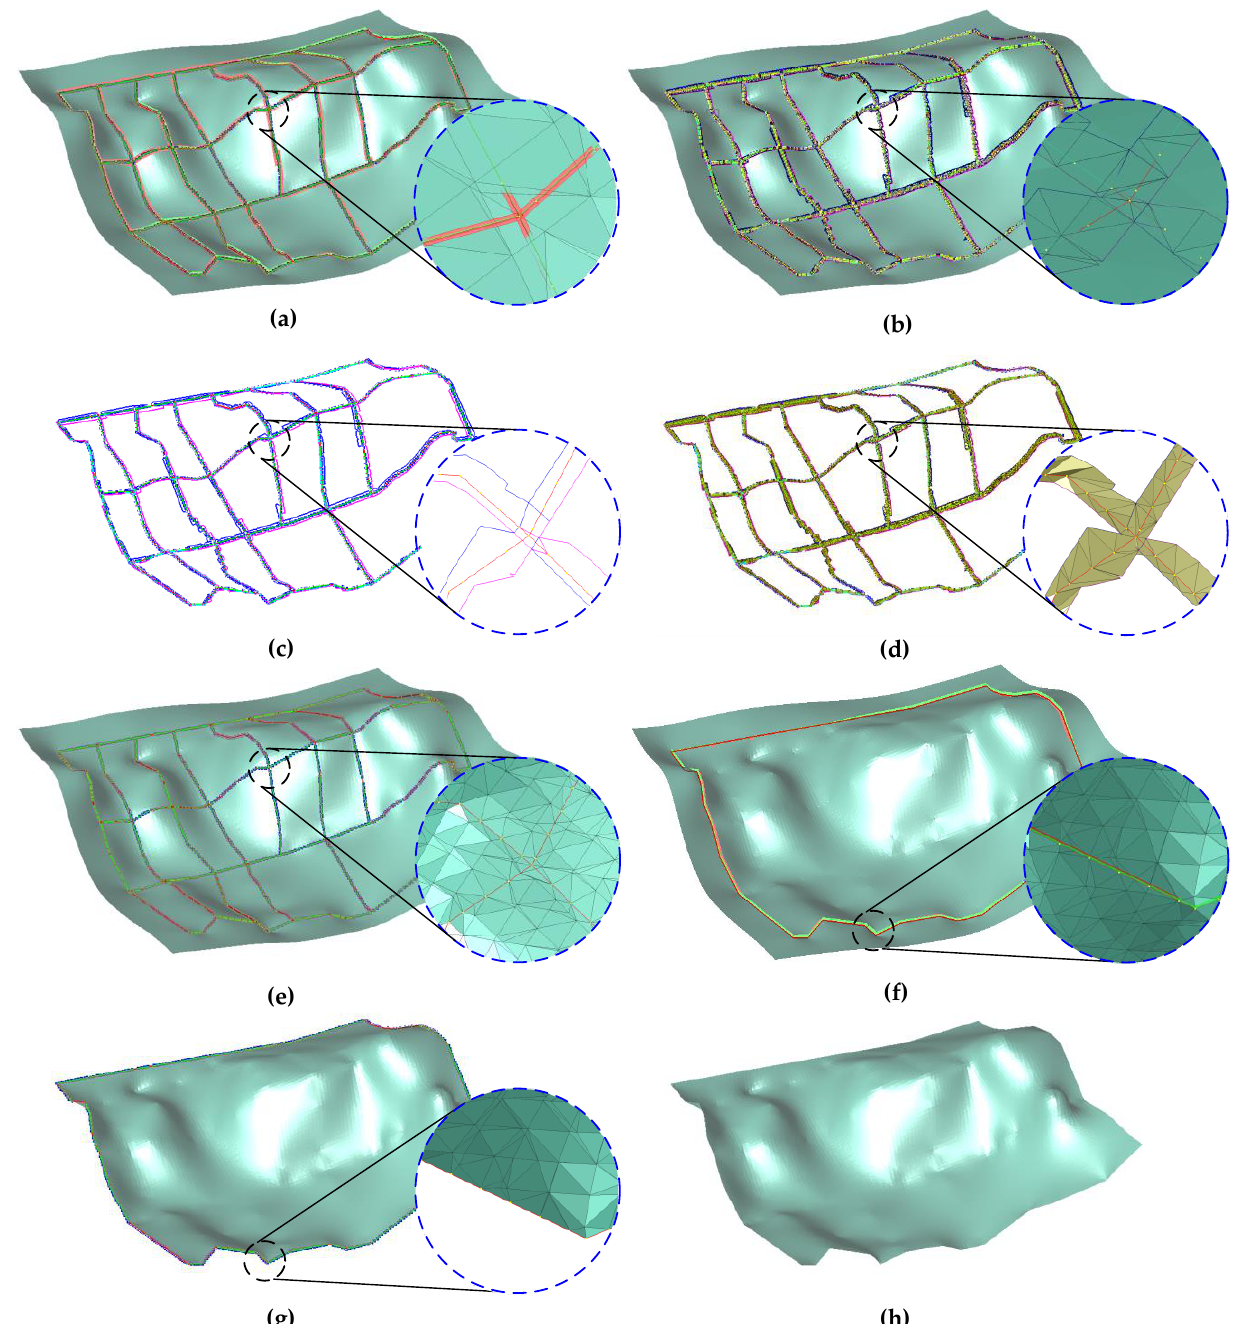
Figure 12. The second group test results of the snapping of feature polylines and the clipping of the model boundary. ( a ) shows constraint polylines and implicit modeling results. ( b ) shows the process of constraint polyline projection and mesh matching. ( c ) shows the matched mesh boundaries. ( d ) shows the re-meshing of the matching meshes. ( e ) shows the results of mesh merging and normal consistency. ( f ) shows the boundary constraint polylines and the model after normal consistency. ( g ) shows the result of mesh boundary clipping. ( h ) shows the orebody model after mesh